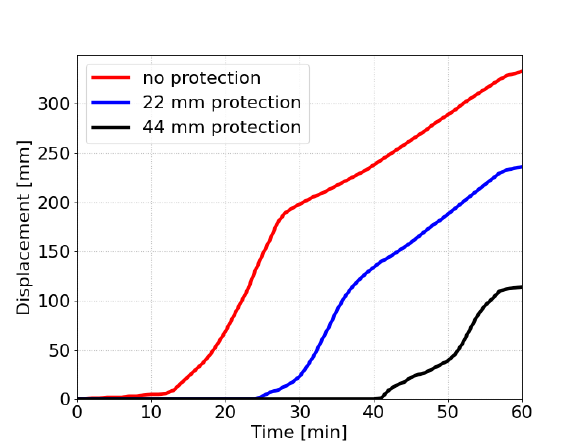
Figure 6. Displacement comparison of the unpro- tected and protected steel